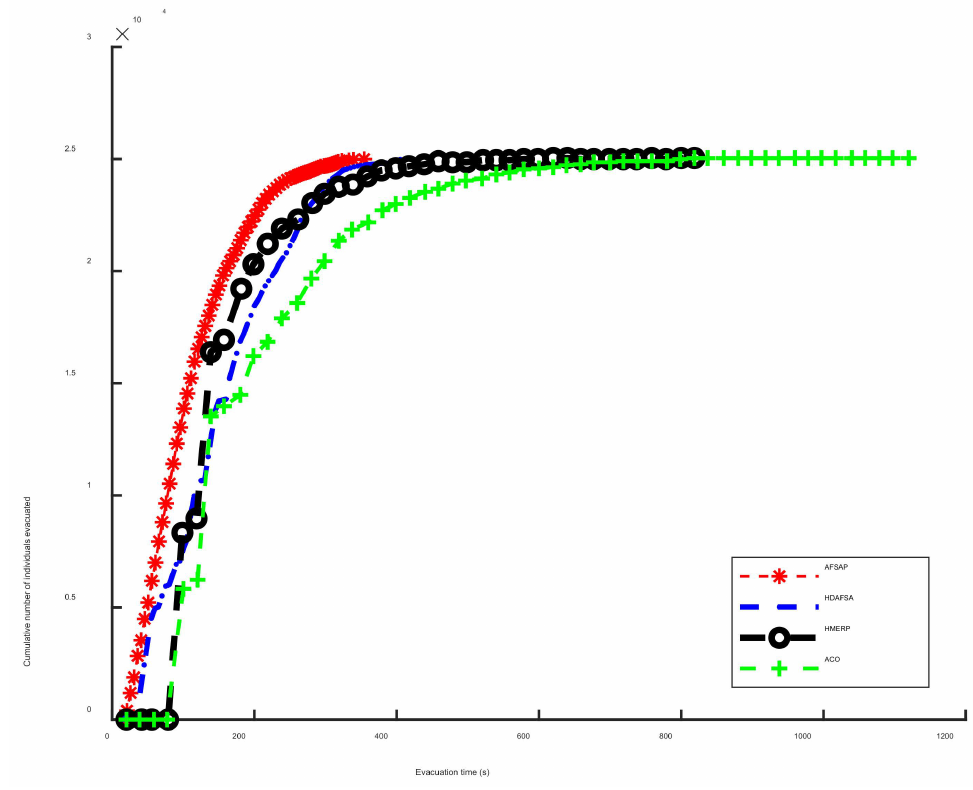
Figure 6. Evacuation efficiency